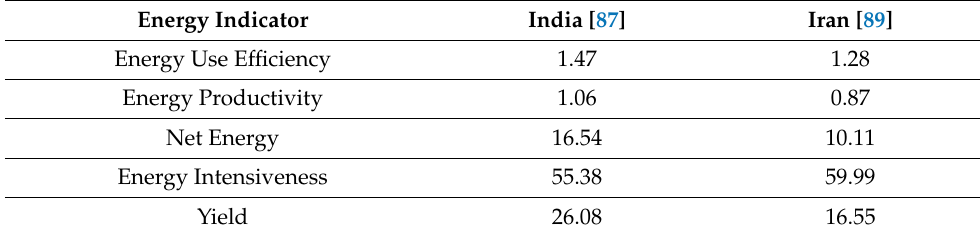
Table 4. Energy indicators comparison of India and